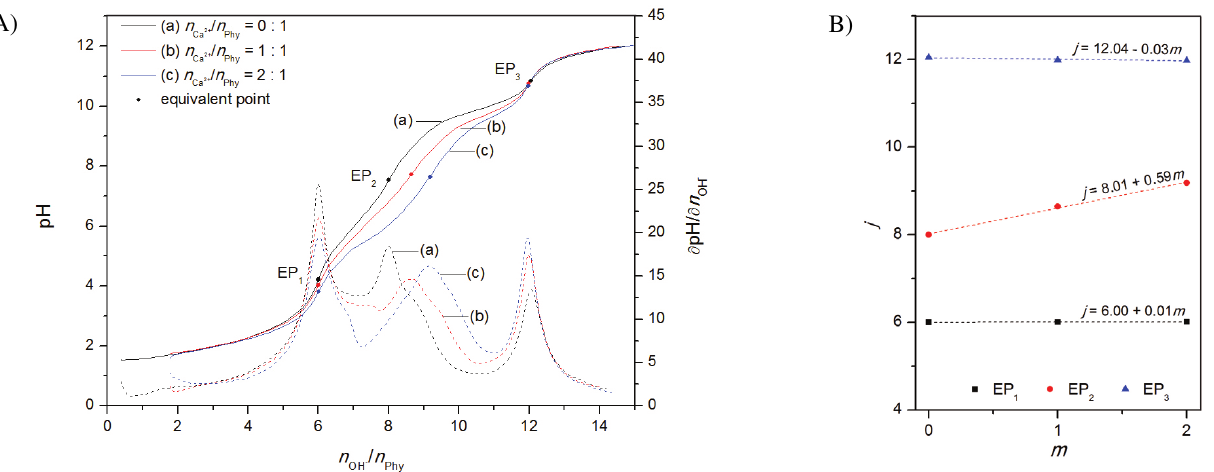
Figure 6. (A) Titration of 0.3104 mmol H 1:1, and (c) 2:1, accompanied with corresponding derivatives ∂ pH/ ∂ n